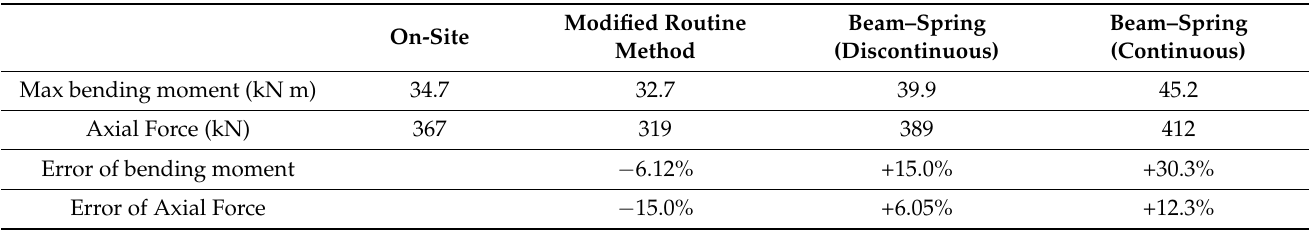
Table 2. The relationship between measured value of internal segment force and calculation value of